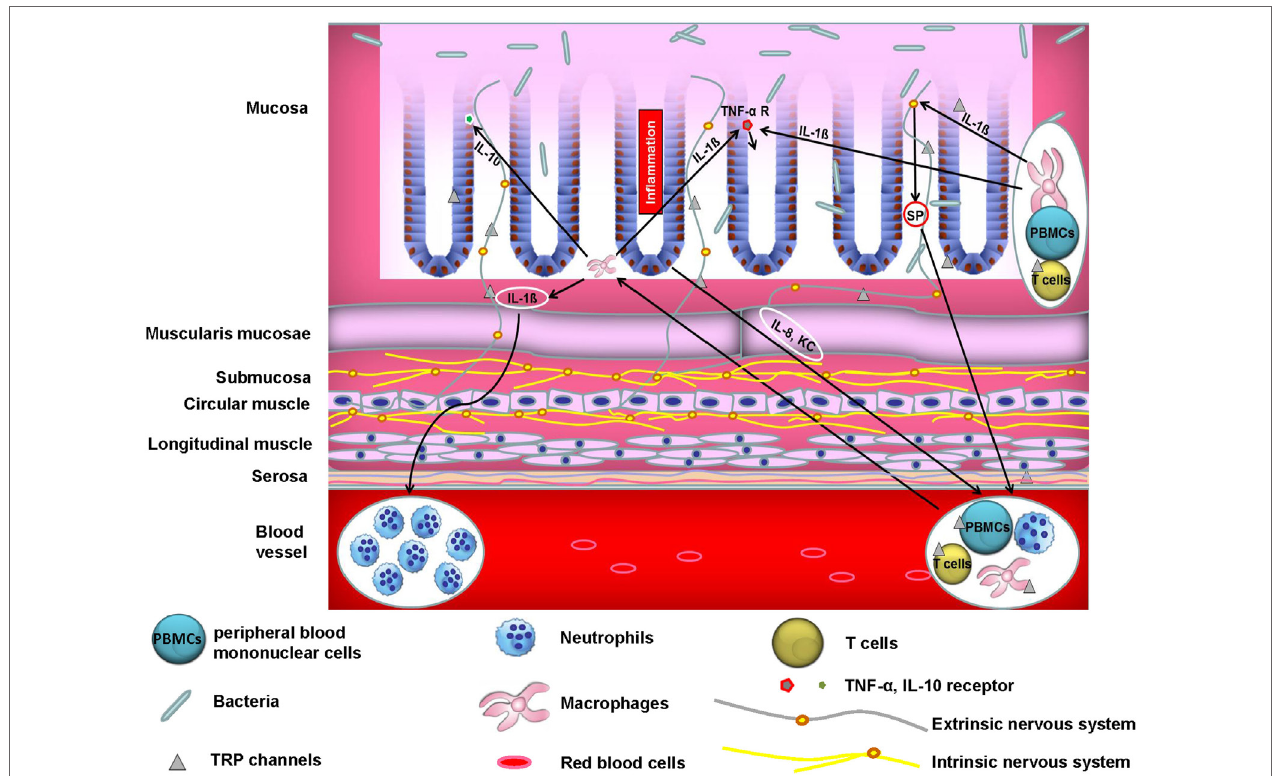
FiGURe 1 | Crosstalk between neurons, immune cells, and epithelial cells controls colonic homeostasis. A vital interplay between neurons, immune cells, and epithelial cells is crucial for colonic homeostasis. Aberrant function of one or more of these players may cause inflammation. For instance, activated macrophages release IL-1ß which among other cytokines acts as a chemoattractant to human peripheral blood mononuclear cells (PBMCs) (45). On the other hand, IL-1ß increases TNF- α receptor expression in epithelial cells which may promote TNF- α -mediated inflammatory responses and subsequently colitis. Moreover, IL-1ß acts on peptidergic sensory neurons through induction of pro-inflammatory substance P (SP) release. SP in turn induces migration of polymorphonuclear leukocytes in vivo (46). In addition, epithelial IL-8 and KC induce immune cell infiltration into the colonic wall. IL-10 is an essential immunoregulatory cytokine (47). Epithelial cells from murine small intestine and colon express the IL-10 receptor and its stimulation blocks IFN- γ -mediated pro-inflammatory effects (48). Moreover, not only epithelial cells but also enteric neurons express cytokines and chemokines such as IL-8, whose neuronal production is promoted by IL-1ß via MAPK signaling pathways